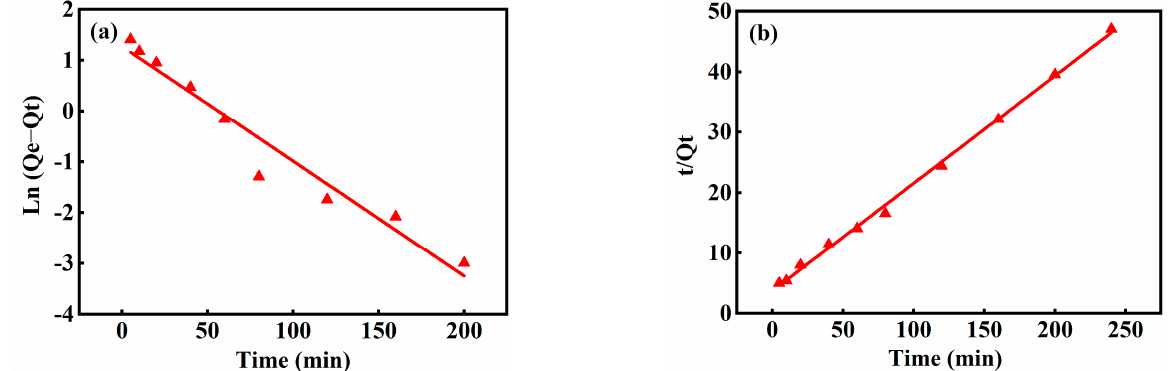
Figure 11. Pb adsorption kinetic model fitting: ( a ) pseudo-first-order model; ( b ) pseudo-second-order model.